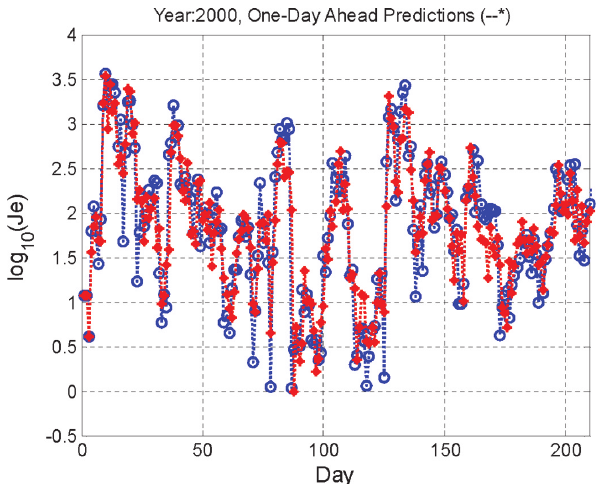
Fig. 3. A comparison between the one-day ahead predictions and the corresponding measurements during a period in year 2000. Note that the model was generated from the initial full model with time lags up to m = 3.